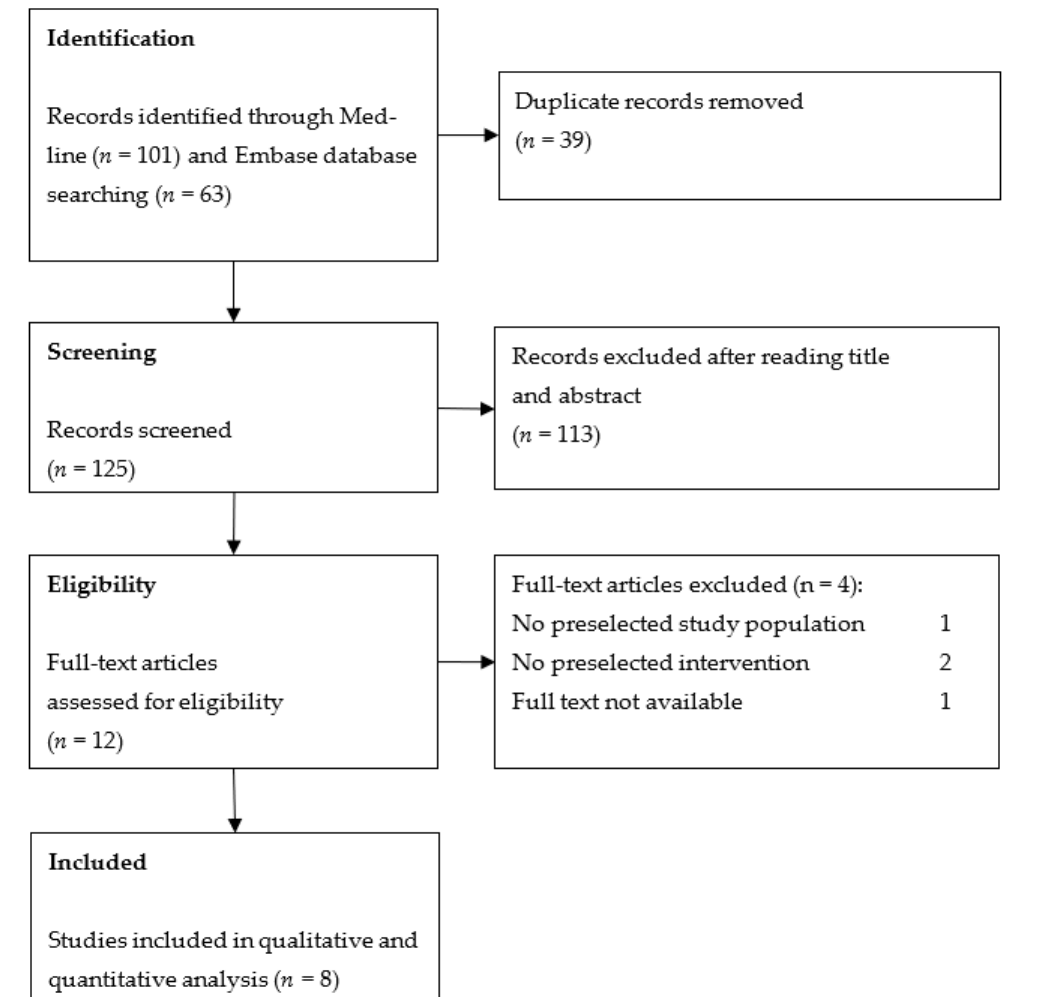
Figure 2. Flow diagram of study selection.